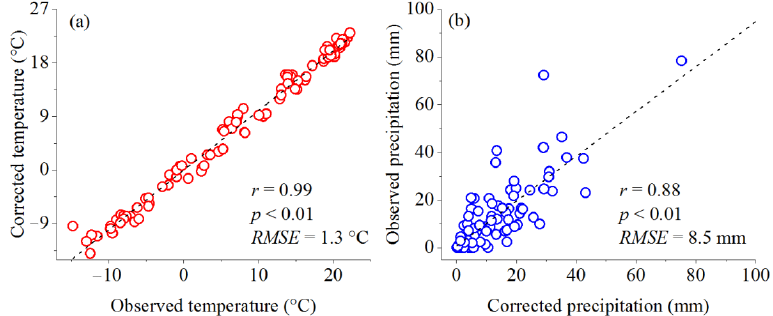
Figure 2. Comparison of the observed temperature data at YHG versus the corrected temperature series at HM ( a ) and the observed precipitation data at YHG versus the corrected precipitation of the grid data ( b ) from January 2003 to December 2010.